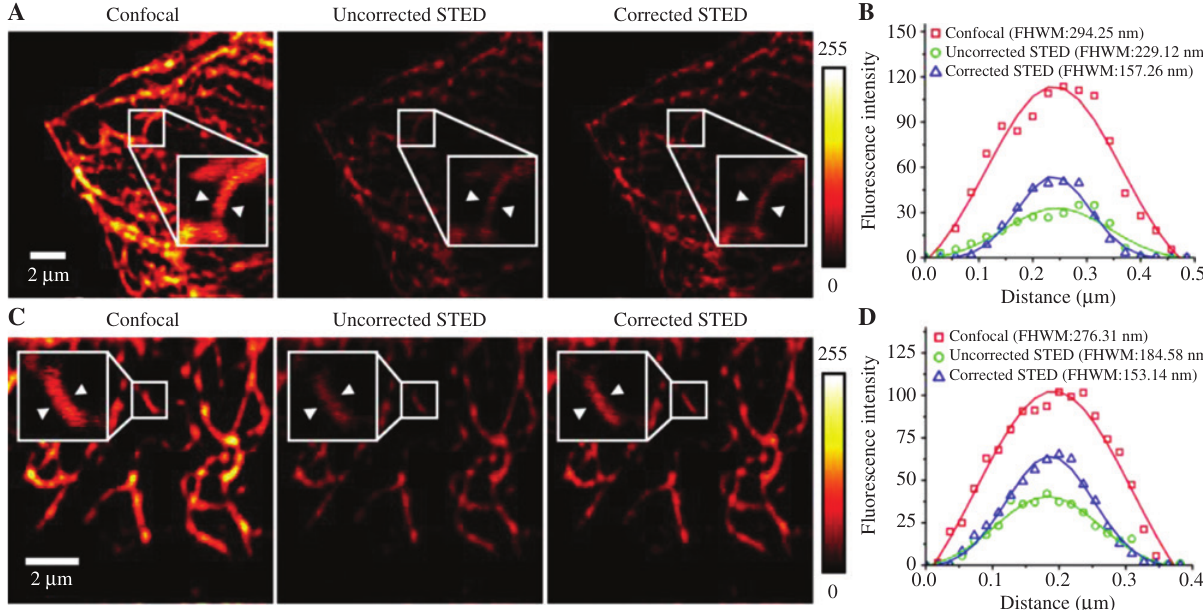
Figure 8: Full aberration correction in Hela cell sample. (A) Images of tubulin structures in a HeLa cell labeled with ATTO647N in the field of view of 15 × 15 μ m 2 . (B) Fluorescence intensity profiles marked by white arrows in (A). (C) Images of tubulin structures in a HeLa cell labeled with ATTO647N in the field of view of 10 × 10 μ m 2 . (D) Fluorescence intensity profiles marked by white arrows in